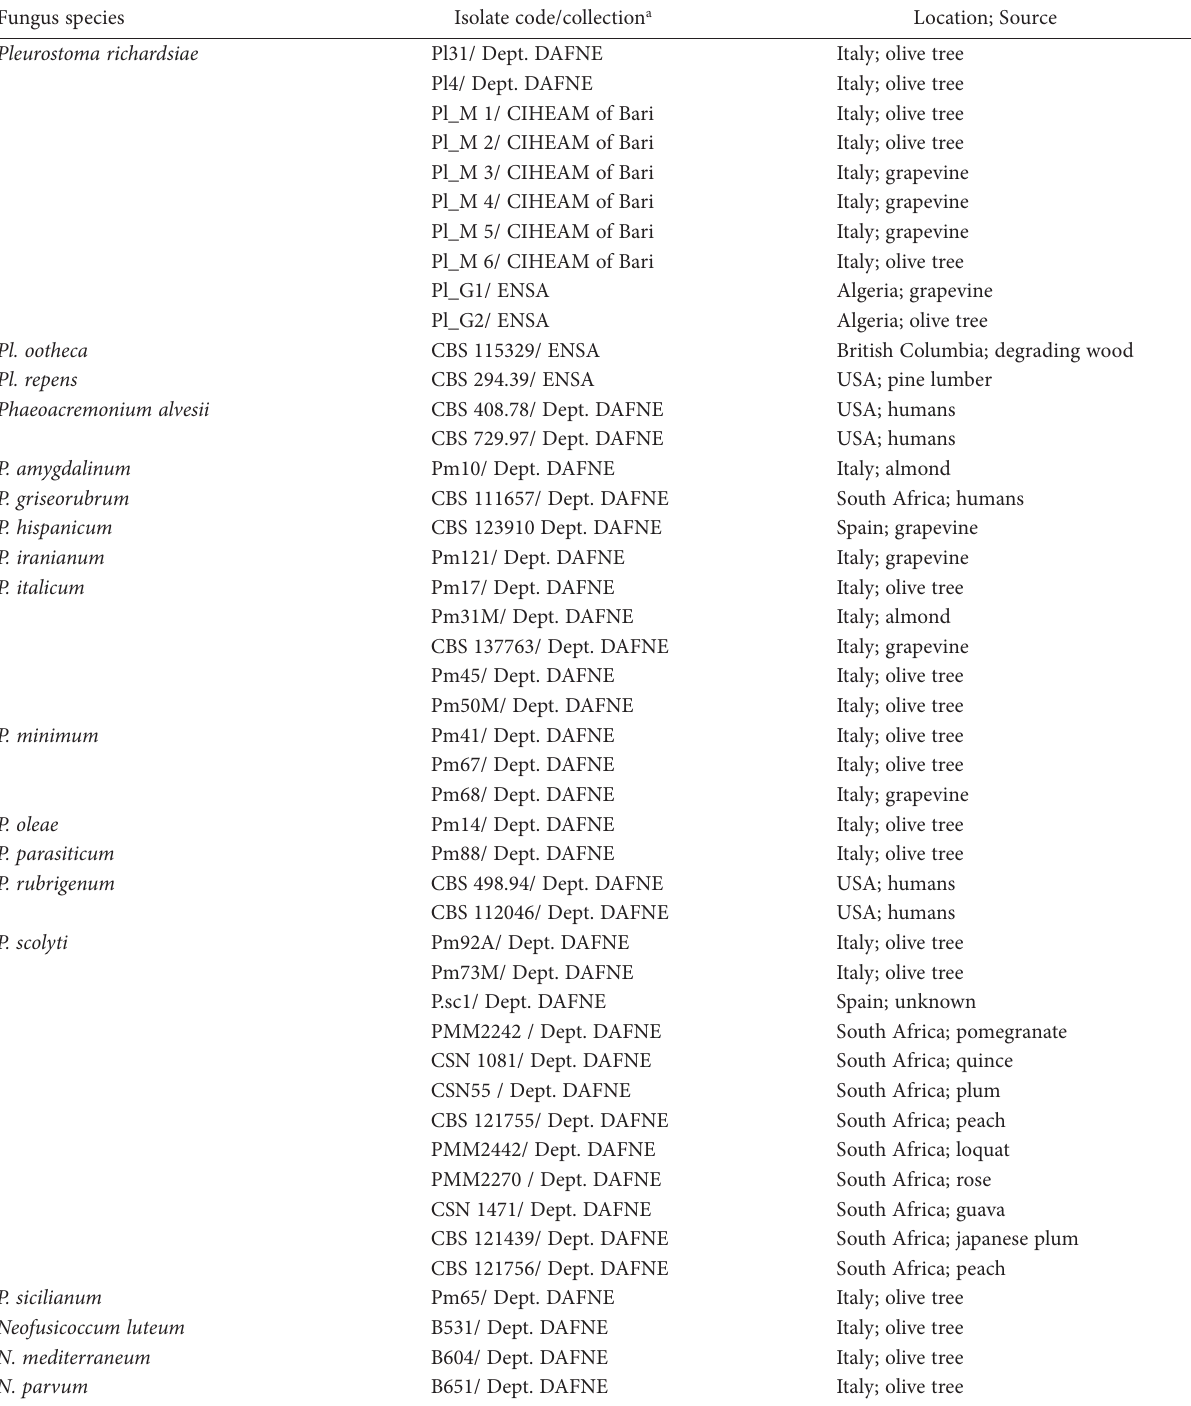
Table 1. List of fungal strains isolated from different sources used in this study. Fungus